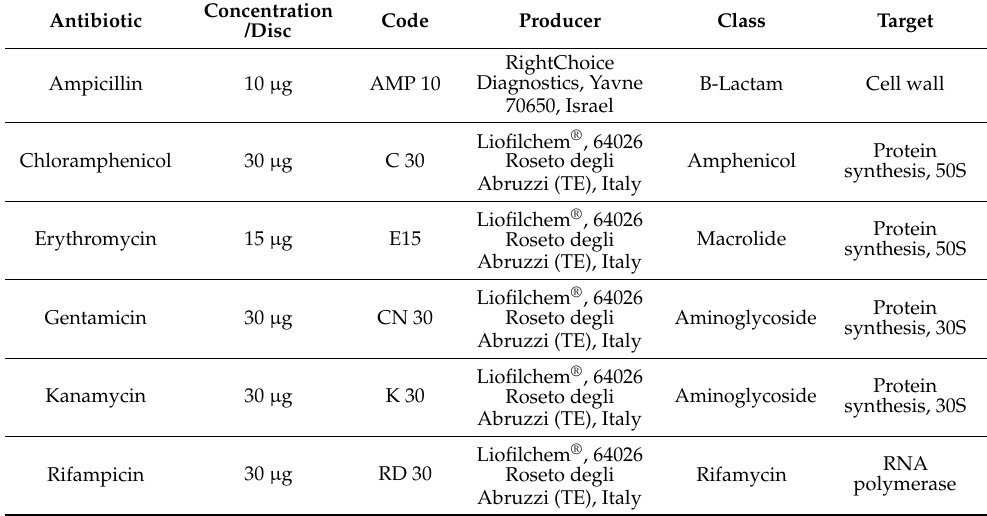
Table 2. List of antibiotics used in the